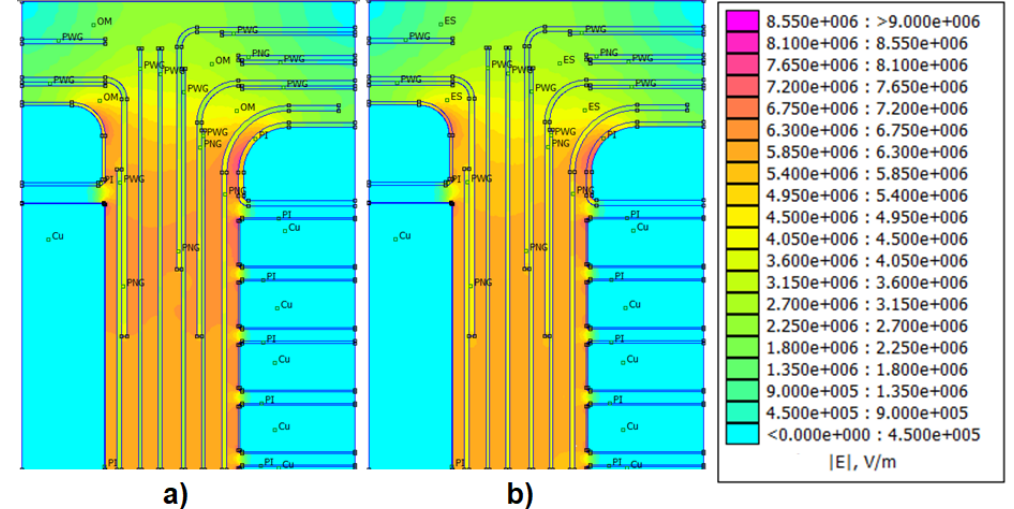
Figure 12. Electric field distribution in simplified insulation structure of power transformer: ( a ) mineral oil, ( b ) synthetic ester.